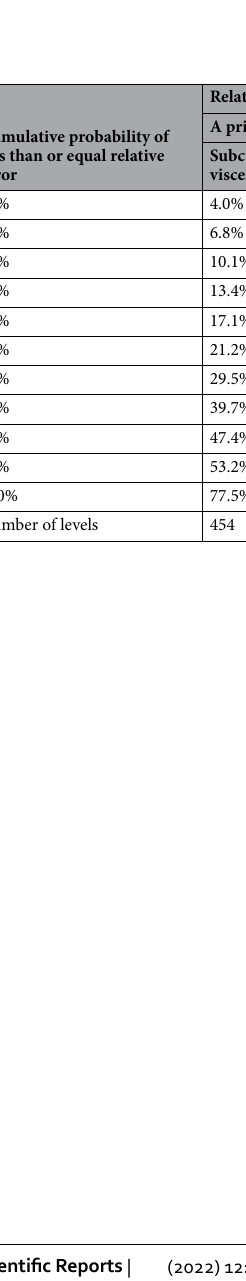
Table 2. Calculated BG per individual IG signal.